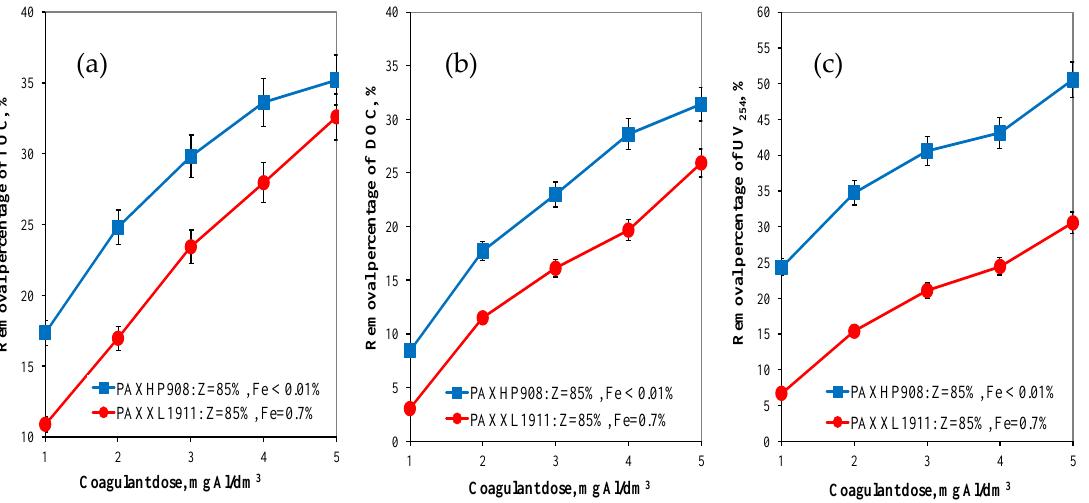
Figure 1. The effect of the type and dose of a coagulant on the efficiency of removing TOC ( a ), DOC ( b ) and UV 254 ( c ).